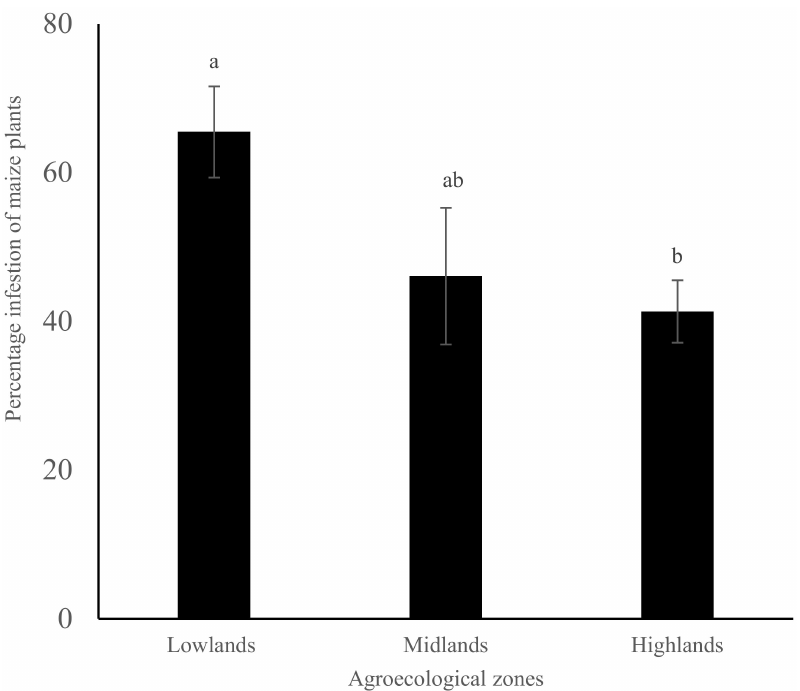
Figure 2. Percentage of maize plants infested (mean ± SE) by fall armyworm in different agro- ecological zones of Kenya. Bars capped with different letter differ significantly (Tukey’s studentized test: p <